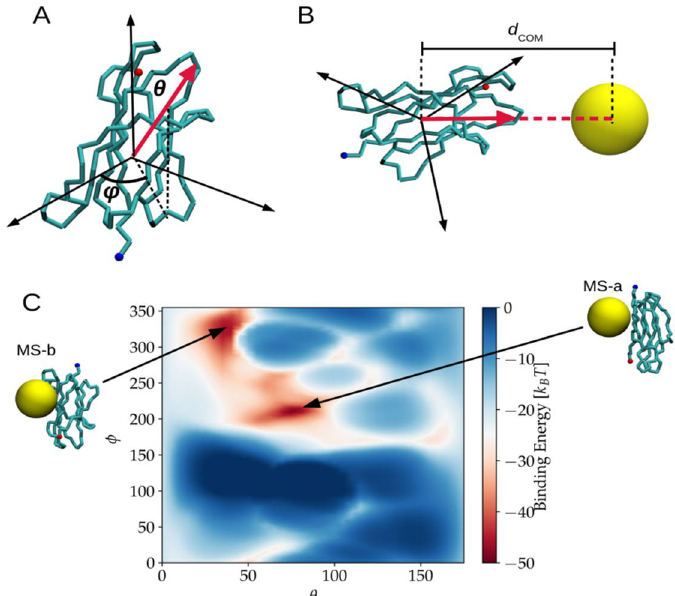
Figure 2. Schematic representation of the energy binding sampling and the binding energies results for the MS model. ( A ) A point on the surface of the protein can be represented by the pair of angles ( Φ , θ ). ( B ) The total potential energy is calculated for each pair if ( Φ , θ ) and a function of the distance from the center of the NP to the COM of the protein, d COM , is known. The binding energy for each orientation is defined as the minimum of the total potential energy. ( C ) Binding energy map for β 2 µ interacting with Au 25 (S(CH 2 ) 2 Ph) 18 − , Red areas show regions in the protein that bind more strongly to the NP.